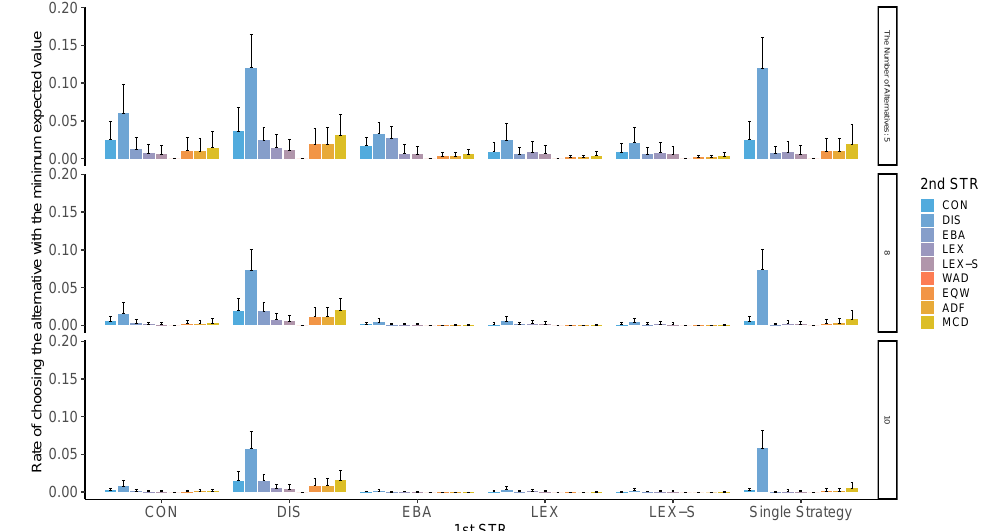
Figure A10. Worst-choice rate in two-stage decision-making when three alternatives are left in the second stage. Note: ADF: additive difference; CON: conjunctive; DIS: disjunctive; EBA: elimination by aspects; EQW: equal-weighted strategy; LEX: lexicographic; LEX-S: lexicographic semi-order; MCD: majority of confirming dimensions; STR: strategy; WAD: weighted